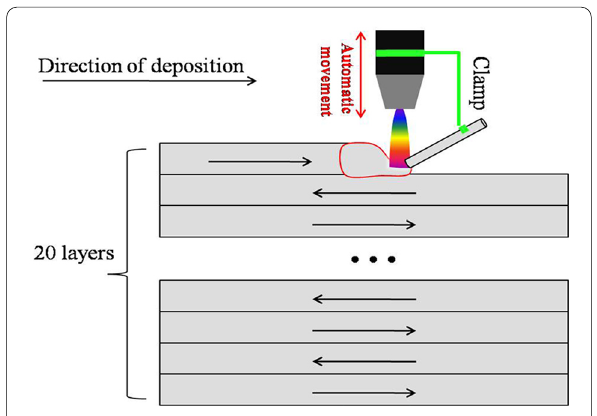
Figure 19 Schematic of deposition of single-walled component using proposed self-adaptive control system